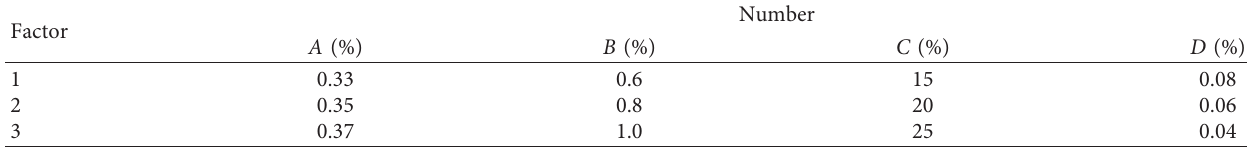
Table 4: The L 4 ) orthogonal factor level table. 9 (3